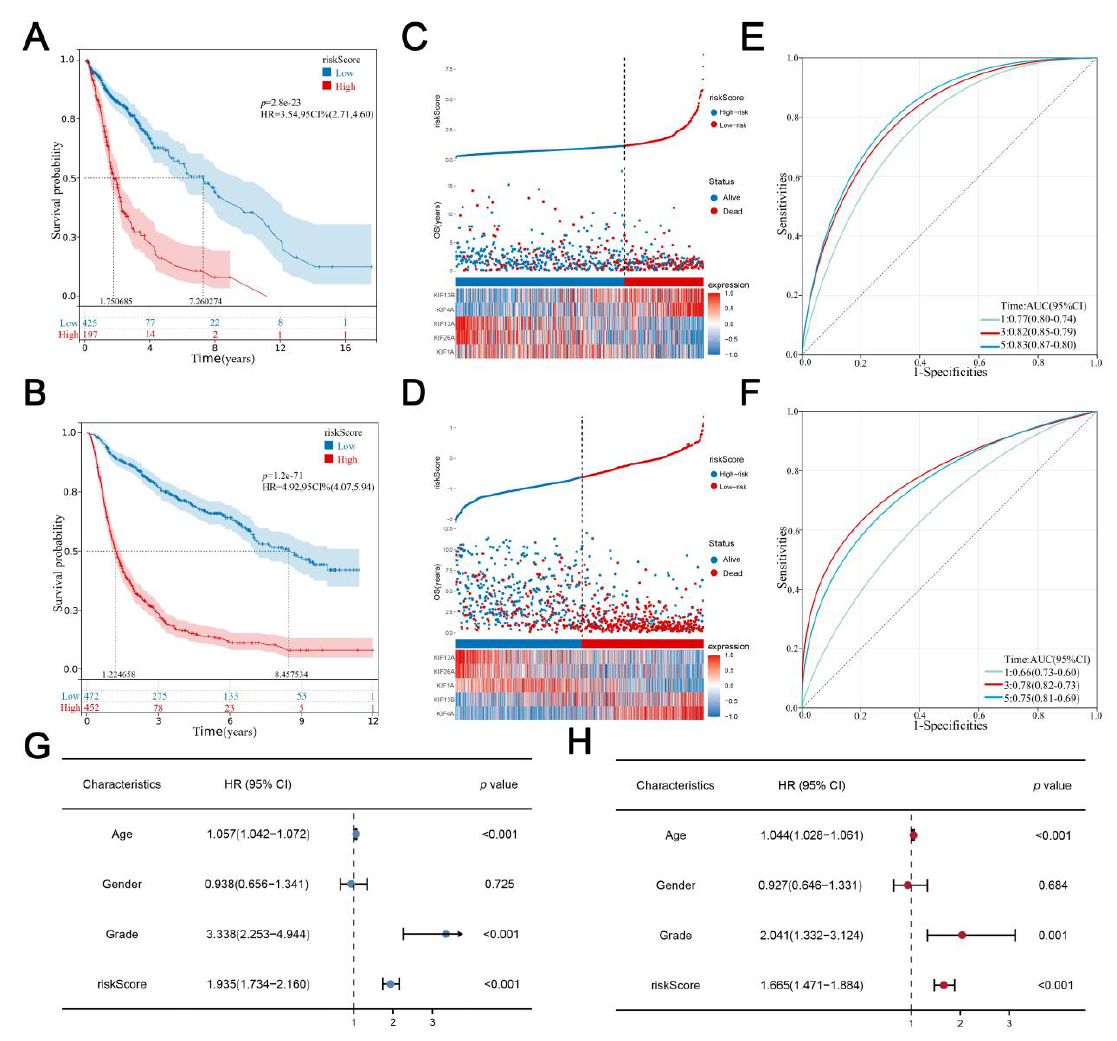
Figure 4. Evaluation and verification of the signature. Notes: ( A , B ) Kaplan–Meier survival curves analysis comparing overall survival between two risk groups in both training and validation cohorts; ( C , D ) the distribution of survival status and survival time of glioma patients with different risk scores as well as the expression levels of 5 prognostic KIFs in both training and validation cohort; ( E , F ) AUC values under the time-dependent ROC curves corresponding for 1, 3, and 5 years of signature was calculated in both training and validation cohort; ( G , H ) univariate and multivariate Cox regression analyses for the risk score as an independent prognostic factor.